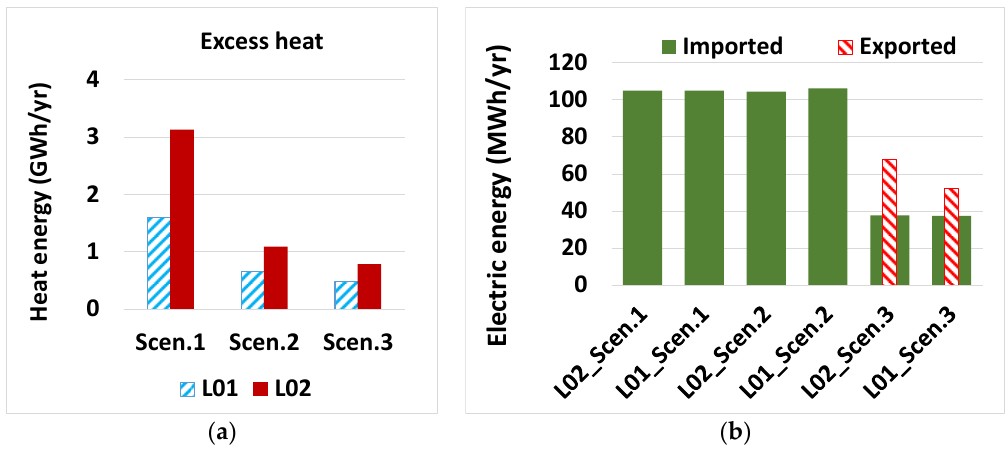
Figure 8. Excess heat ( a ) and imported/exported power to/from the grid ( b ) for the two load profiles (L01 and L02) and the three scenarios.